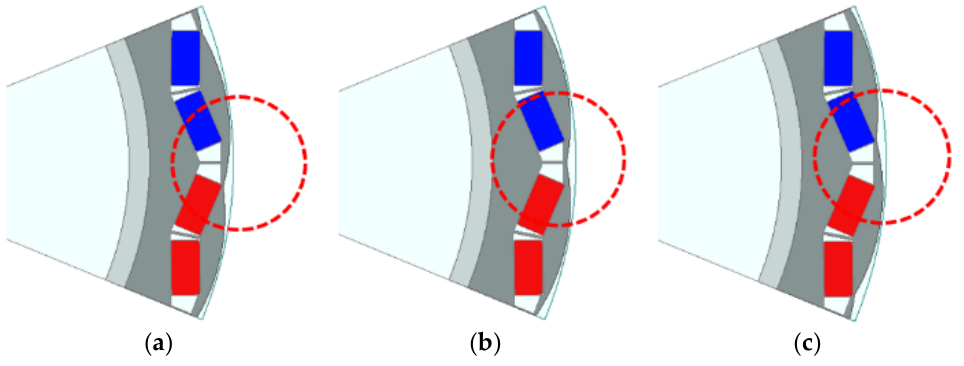
Figure 8. Tapering skew angles: ( a ) − 3.5 deg, ( b ) 0 deg, and ( c ) 3.5 deg.